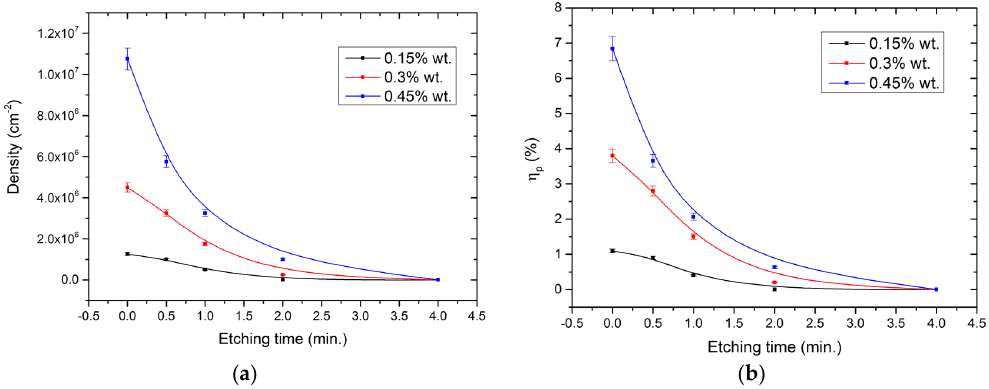
Figure 5. Nucleation particle density ( a ) and relative area of parasitic particles ( b ) against etching time in regions without a film. Table 1. Effect of reactive ion etching on the concentration of parasitic particles in regions without a film.